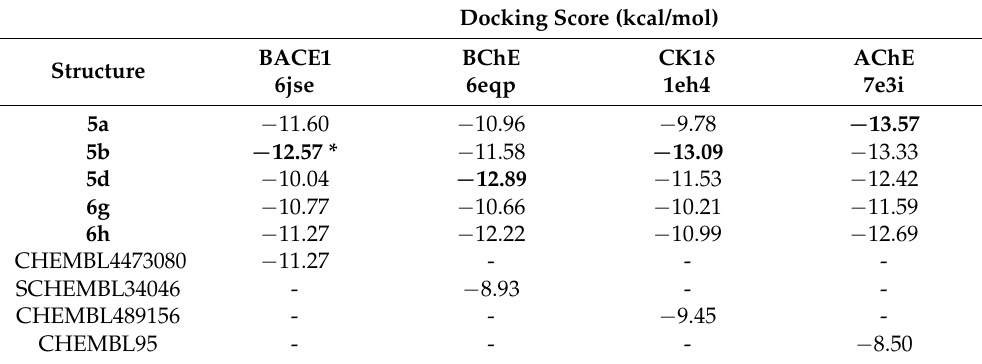
Table 1. Results from the protein–ligand docking for targets responsible for the progression of neurodegenerative diseases (Bold for the best docking score). Docking Score (kcal/mol) BACE1 Structure 6jse